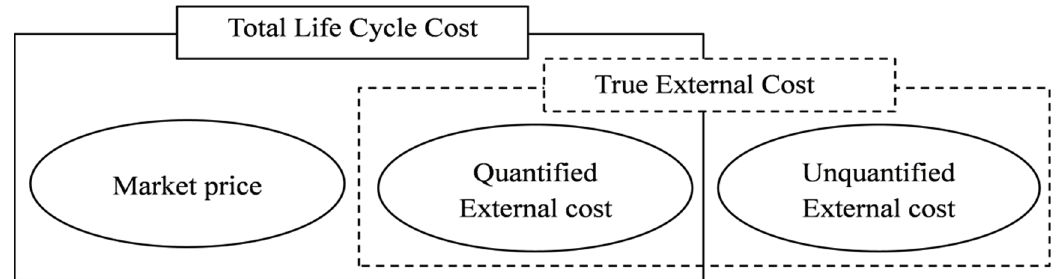
Figure 8. Relationship of total lifecycle cost and true external